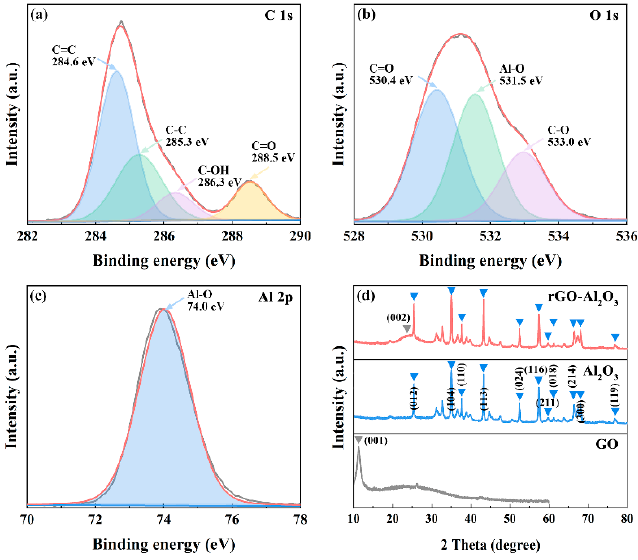
Figure 3. ( a ) C 1s, ( b ) O 1s, ( c ) Al 2p XPS spectra of the rGO-Al 2 O 3 nanocomposite, and ( d )